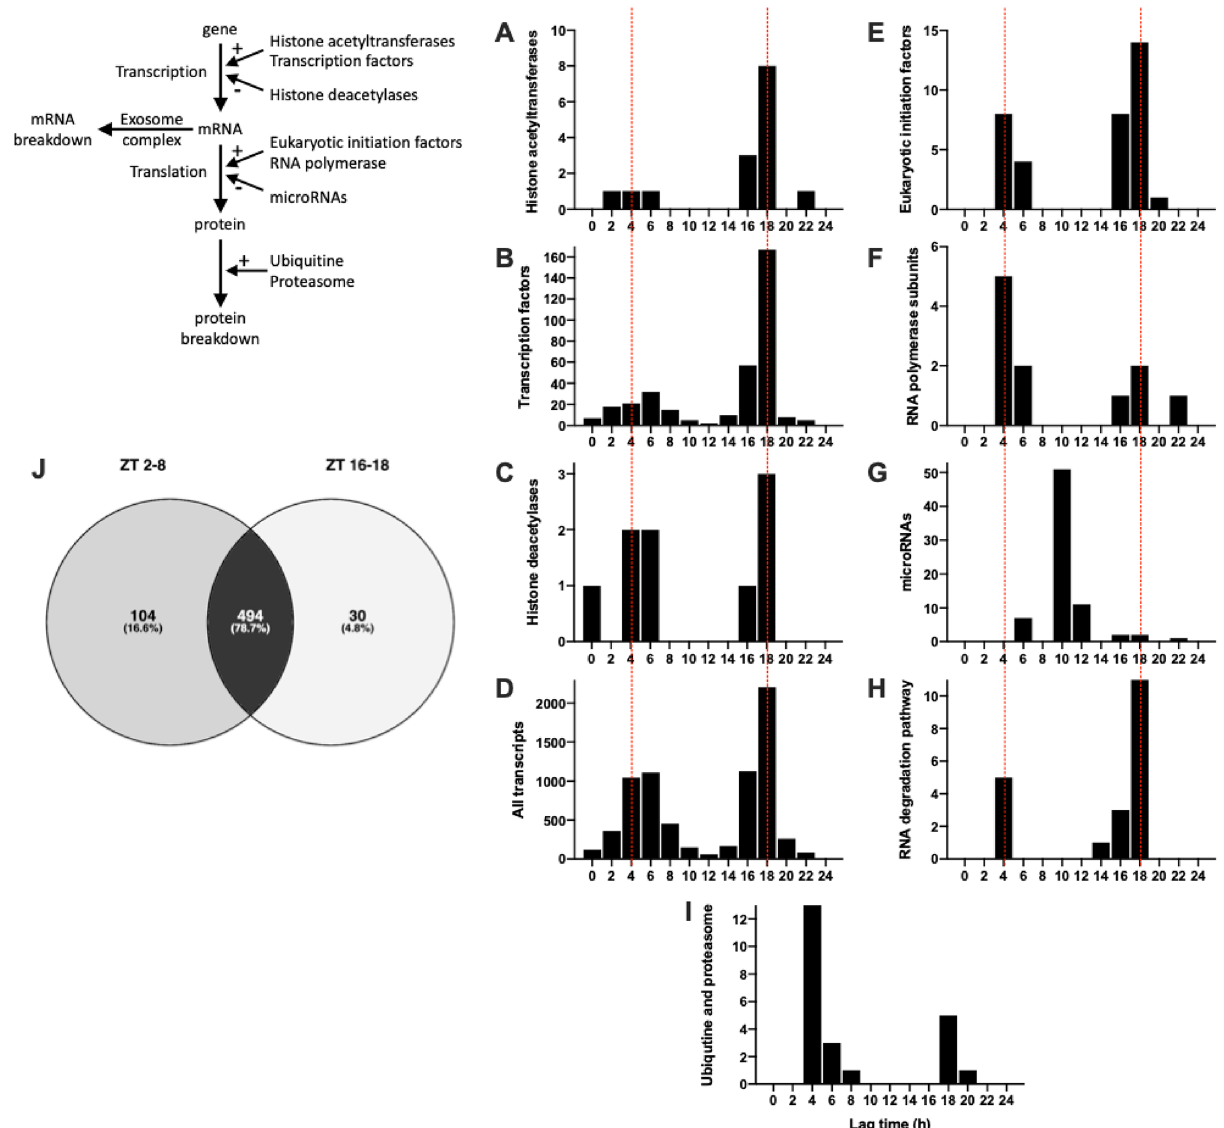
Figure 7. Transcription, translation, and mRNA transcript and protein breakdown. ( A – I ), histogram of lag times (times of peak transcript abundance) of different groups of transcripts involved in transcription, translation, and mRNA transcript and protein breakdown. ( J) , Venn diagram of pathways involving the transcripts peaking during the day and night; data were analysed through the use of IPA (QIAGEN Inc., https:// www. qiage nbioi nform atics. com/ produ cts/ ingen uityp athway- analy sis) 103 . Inset, schematic diagram of the cycle of transcription, translation, and RNA and protein